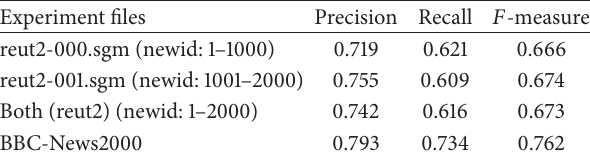
Table 7: Experimental results of